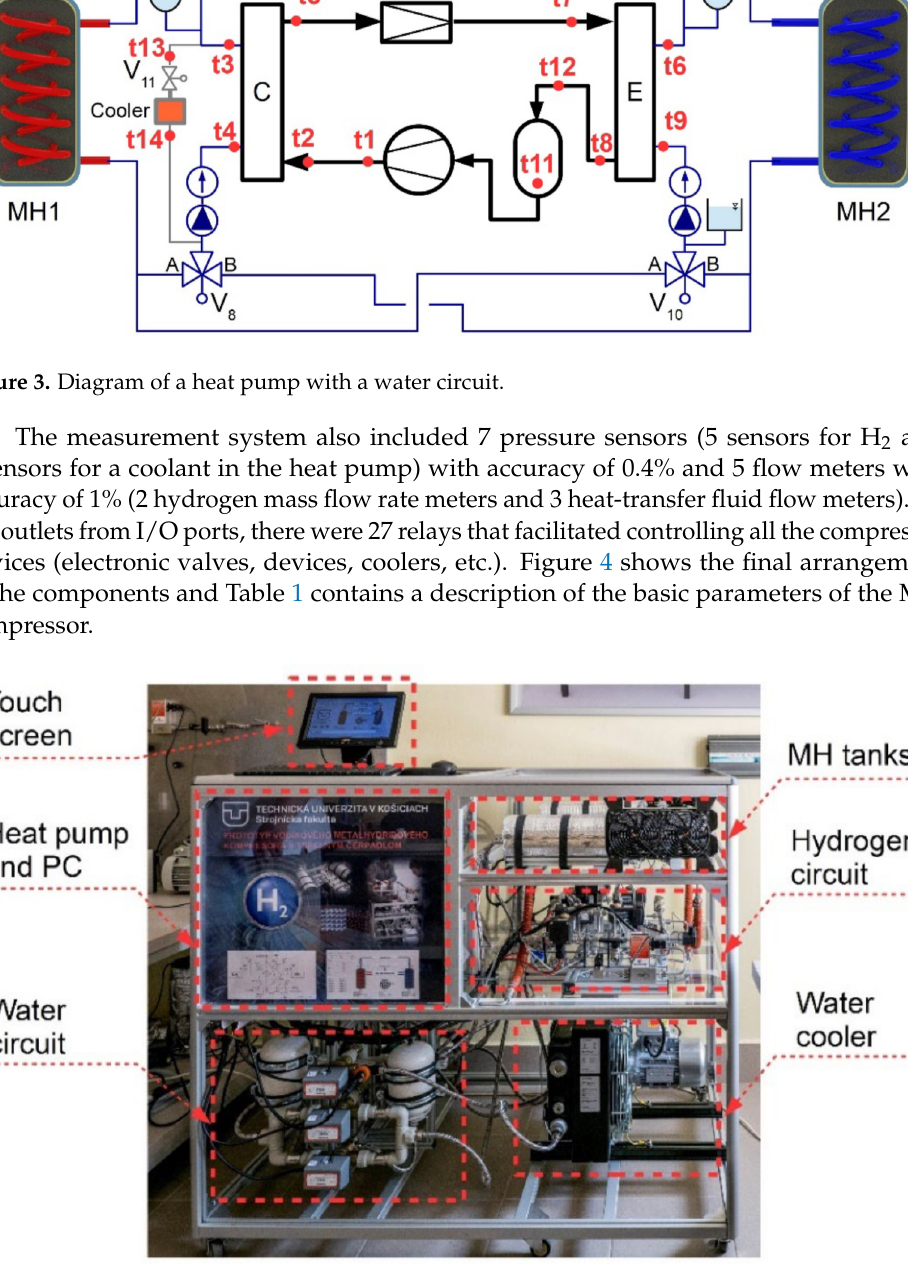
Figure 4. MH compressor with a heat